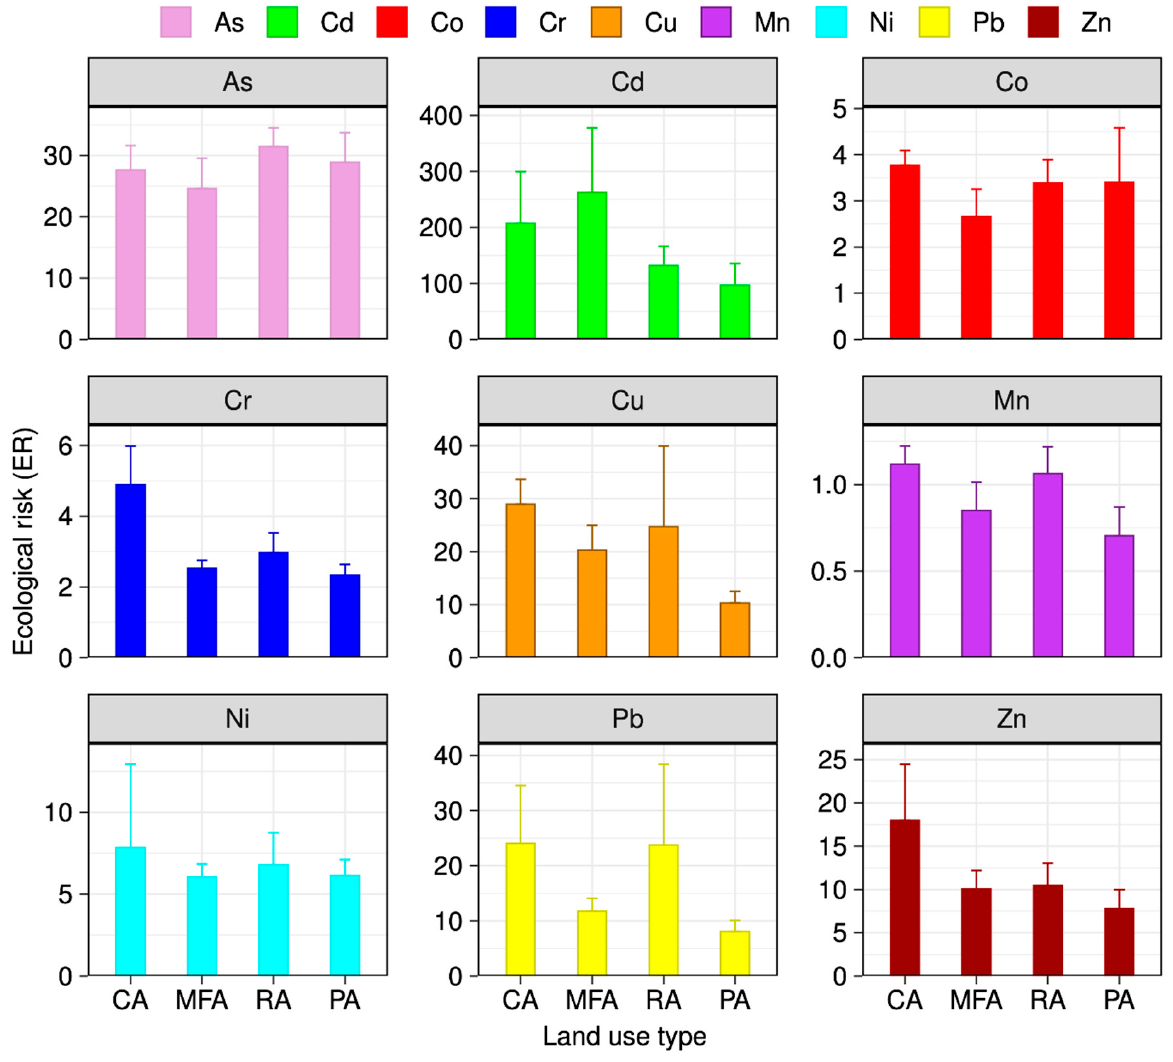
Figure 7. Ecological risk (Er) of each toxic metal (As, Cd, Co, Cr, Cu, Mn, Ni, Pb, and Zn) in road dust of Mymensingh City. CA = commercial areas, MFA = medically facilitated areas, RA = residential areas, PA = park